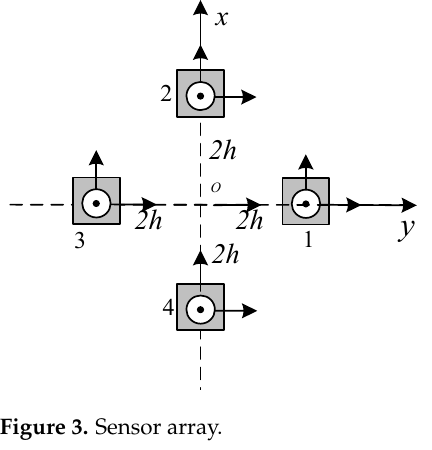
Figure 3. Sensor array.